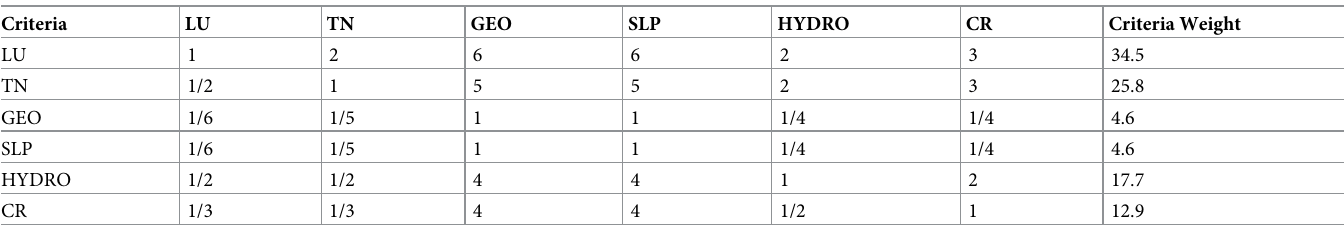
Table 2. Pairwise comparison of criteria giving a higher weighting to land use. Criteria